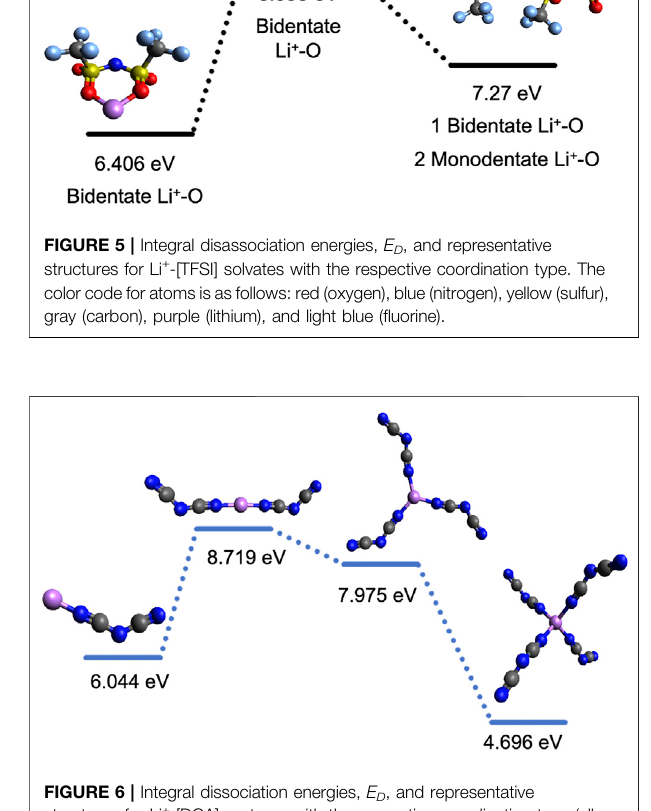
FIGURE 6 | Integral dissociation energies, E D , and representative structures for Li + -[DCA] systems with the respective coordination type (all monodentate Li + -N). The color code for the atoms is as follows: blue (nitrogen), gray (carbon), and purple